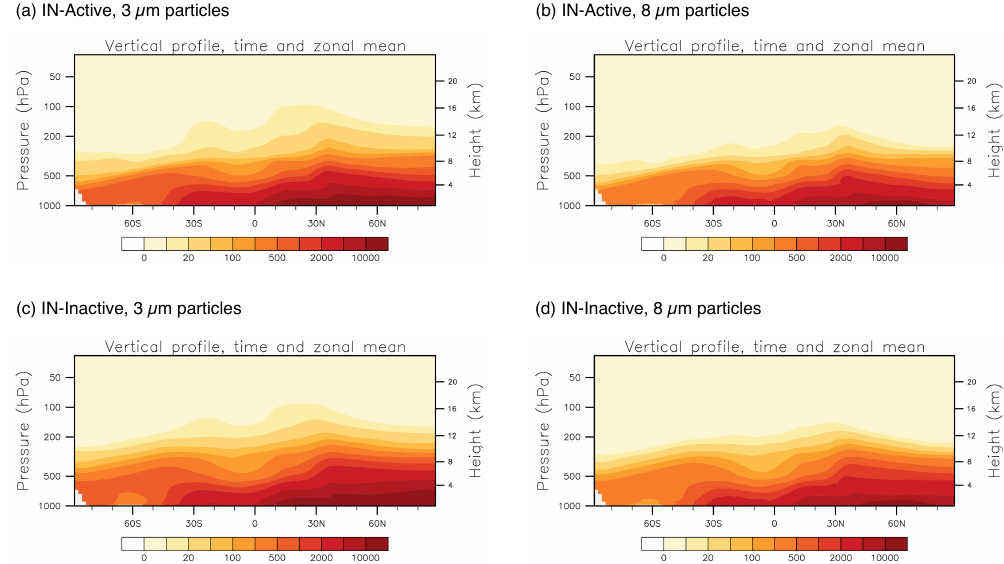
Figure 10. Annual zonal mean spore concentrations (m − 3 ) in each global model simulation. (a) IN-Active, 3µm particles; (b) IN-Active, 8µm particles; (c) IN-Inactive, 3µm particles; and (d) IN-Active, 8µm